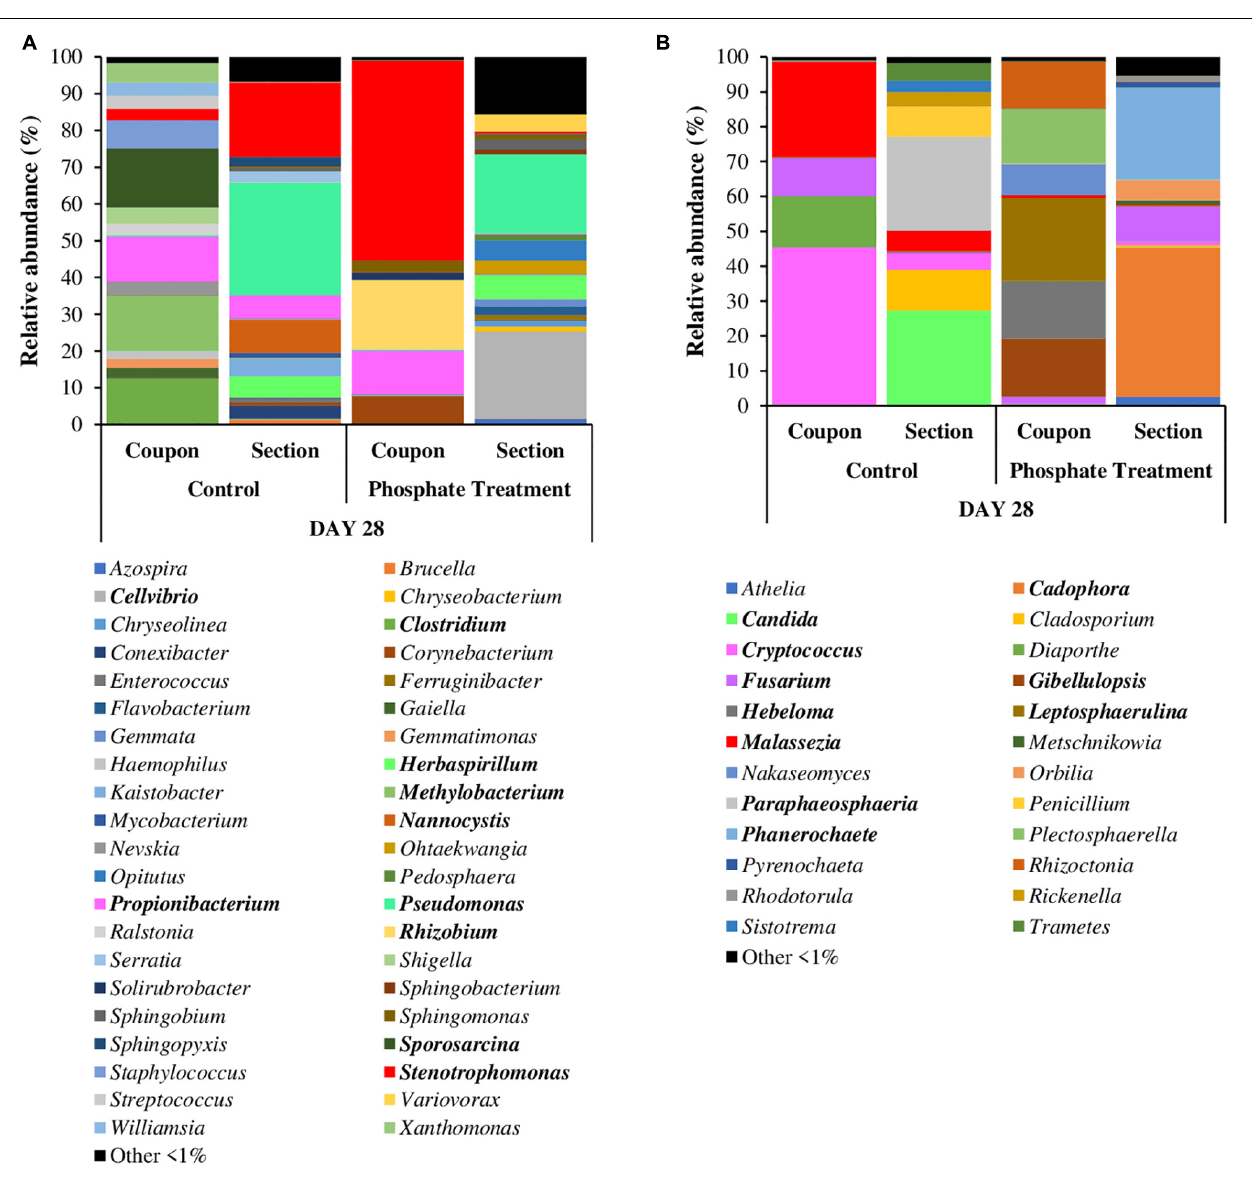
FIGURE 5 | Relative abundance of most abundant bacterial (A) and fungal (B) genera in coupons and sections. It is shown the average of relative abundance of the most abundant bacterial and fungal genera ( n = 3) at 28 days of different treatments (phosphate treatment and control) and in coupons and section samples. The most abundant genera are those which have a relative abundance up to 1% in all the